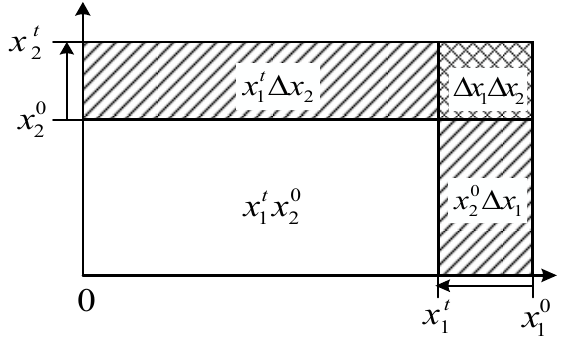
Figure 1. Index change when two factors change at different directions.